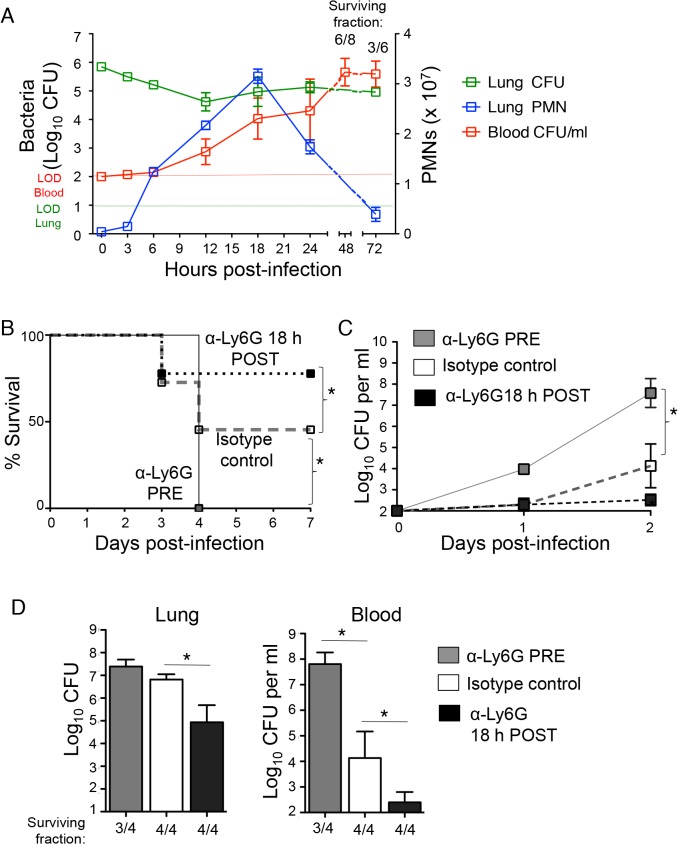
PMNs promote pulmonary and systemic disease during later stages of S. pneumoniae lung infection.(A) C57BL/6J mice were inoculated I.T with 5x105 CFU of S. pneumoniae TIGR4 and pulmonary (green) and bloodstream (red) bacterial loads, as well as pulmonary PMNs (blue) were monitored through 72 hours post-infection. Shown are representative data from one of two separate experiments (using 3 to 4 mice per time point). The numbers above the graph represent the fraction of surviving mice within that group at the corresponding time. (B-D) C57BL/6J mice were treated i.p with PMN depleting antibodies (anti-ly6G) or isotype control either 18 hours pre or post pulmonary challenge with 5x105 CFU of S. pneumoniae TIGR4. Survival (B) and bacterial burdens in the blood (C) were monitored over time and shown are pooled data from two separate experiments. (D) Pneumococcal burdens in the lungs and blood were determined 3 days post-infection. The numbers below the graph represent the fraction of surviving mice within that group. Representative data from one of 4 separate experiments with 3 to 4 mice per group are shown. Means +/- SEM are given in Panels A, C and D, and values significantly (p<0.05) different from isotype control-treated group by Student’s t-test are indicated by asterisk. In Panel B, asterisk indicates survival rate was significantly (p<0.05) different from isotype control-treated controls by Log-rank (Mantel-Cox) test.